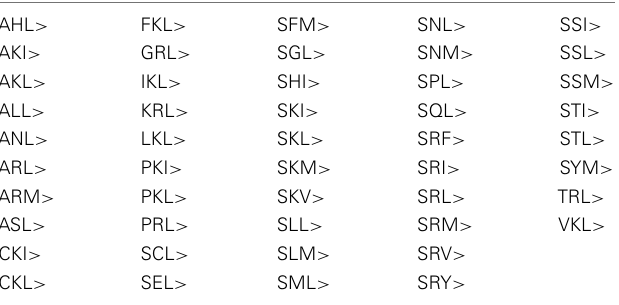
TableA1 | Overview table of experimentally validated plant PTS1